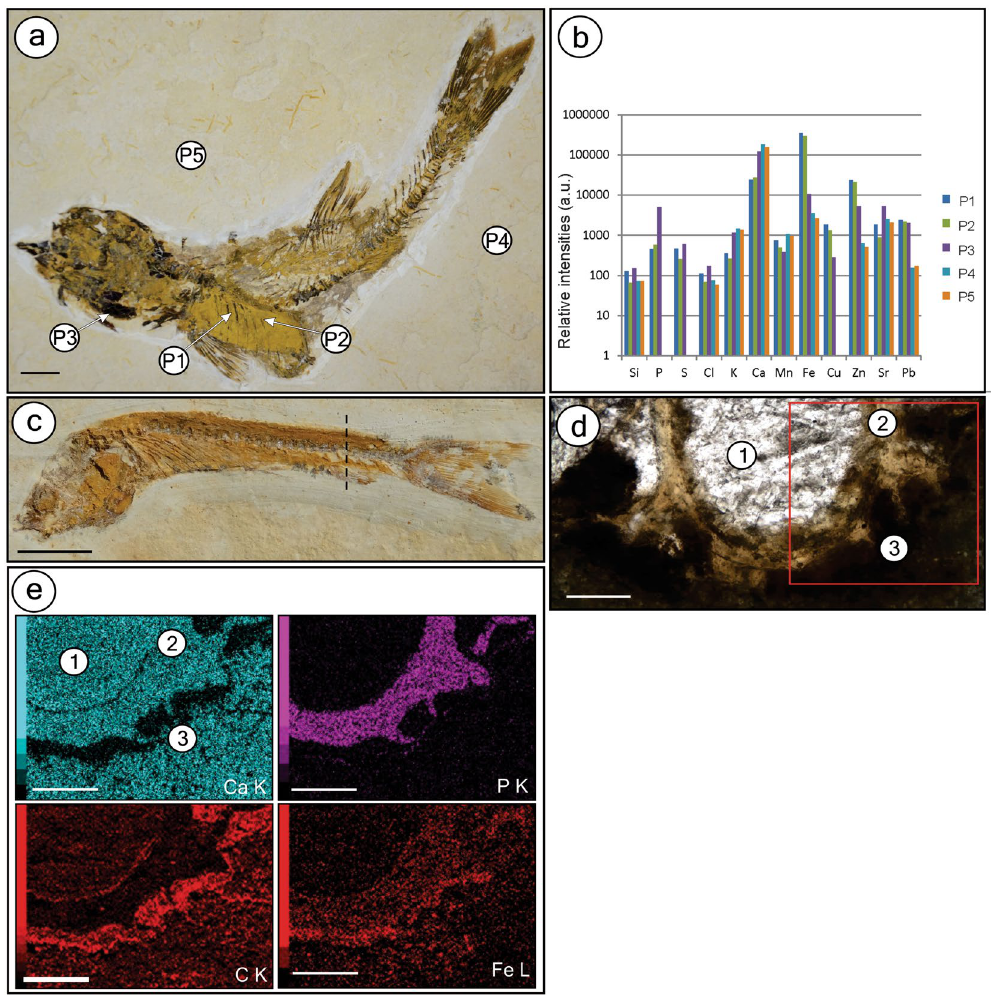
Figure 4. Geochemistry of the Crato Member fossil fish from BL. ( a ) Specimen GP/2E 9014 from BL with points (P1, P2 – decayed soft-tissue area; P3 – bones; P4, P5 – matrix) analyzed in ( b ). ( b ) EDXRF results of the selected points in fossil depicted in ( a ). ( c ) Fossil GP/2E 7781 g. The dashed line indicates the approximate direction of thin section in ( d ). ( d) Thin section (GP/L 20) of specimen in c depicting calcite cement filling vertebrae (1), vertebrae (2), and soft-tissues (3) around vertebrae. The red square delimits the area analyzed in ( e) . ( e) Energy dispersive X-ray (EDS) maps of several elements distributed among the three main regions (1–3) in ( d) Scale bars: ( a) – 1 cm; ( c) – 0.5 cm; ( d) – 0.1 mm; ( e) – 0.1